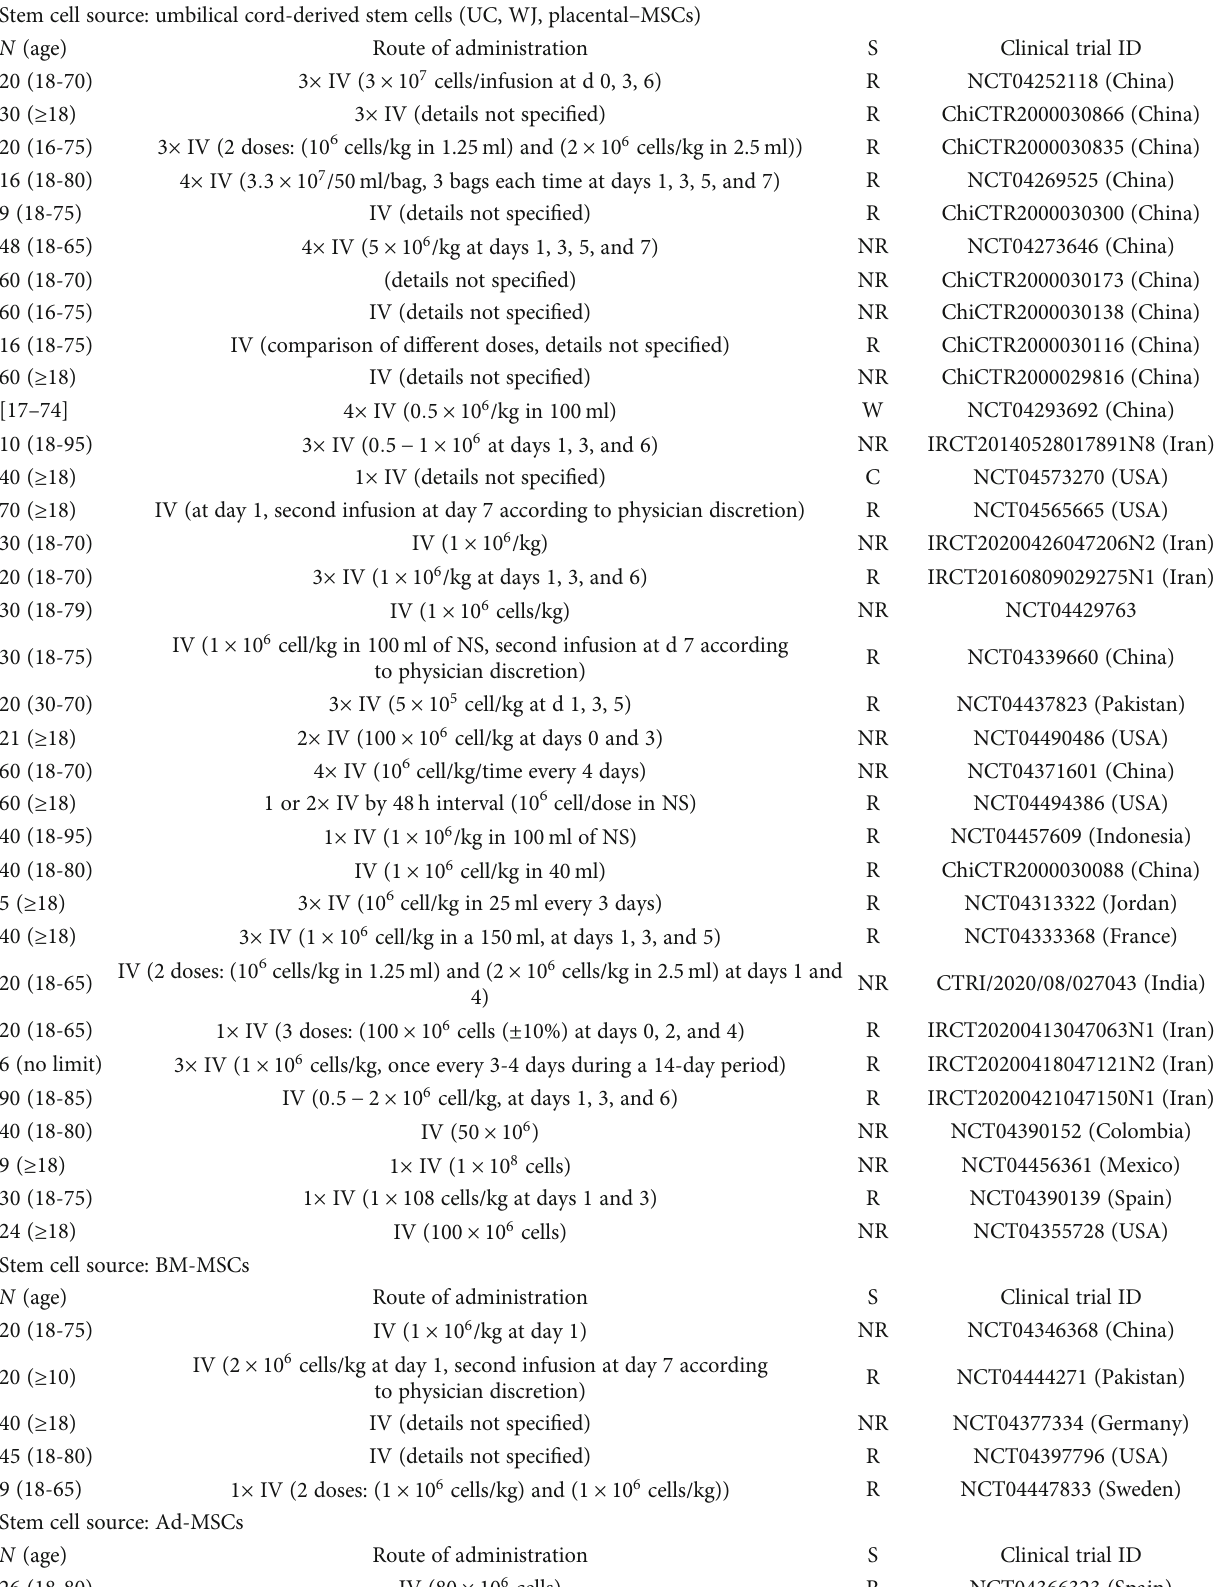
Table 1: A brief review of recent clinical trials using stem cell-based therapy for treatment of COVID-19. Stem cell source: umbilical cord-derived stem cells (UC, WJ, placental –